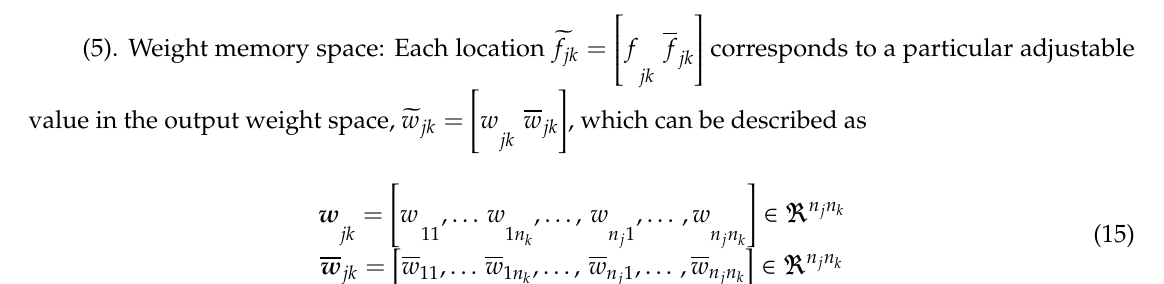
Figure 4. Mechanism for mapping two-dimensional inputs in the association memory space.